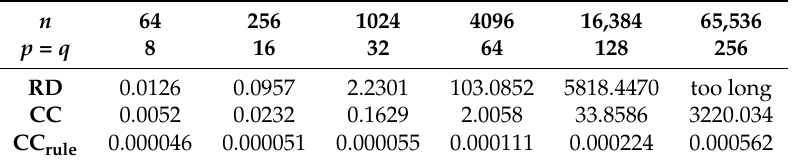
Table 1. Comparison of the order sequence generation time (s) for RD and our cake-cutting